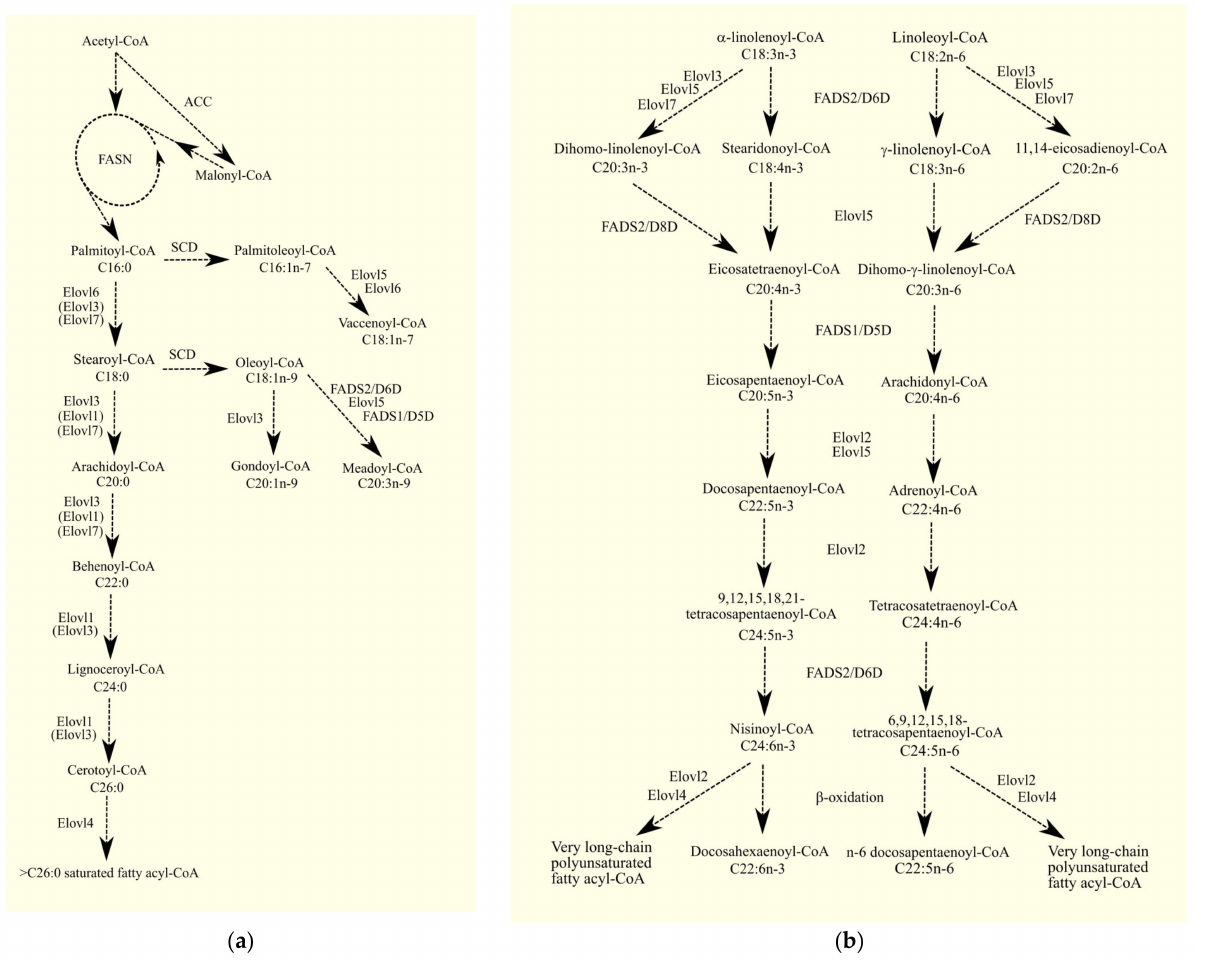
Figure 1. Pathways of fatty acid synthesis. ( a ) The majority of fatty acids are synthesized de novo. Initially, FASN synthesizes palmitoyl-CoA C16:0, but it is unable to elongate the chain further. There- fore, elongases are responsible for the biosynthesis of SFAs longer than 16 carbons. These enzymes elongate fatty acyl-CoA chains by two carbons. Additionally, double bonds can be introduced into acyl-CoA by desaturases. SCD is responsible for the conversion of SFAs to MUFAs, producing oleoyl-CoA C18:1n-9 from stearoyl-CoA C18:0 and palmitoleoyl C16:1n-7 from palmitoyl-CoA C16:0. The desaturases FADS1/D5D and FADS2/D6D are involved in the formation of PUFA, such as meadyl-CoA C20:3n-9, from oleoyl-CoA C18:1n-9. ( b ) In the case of omega-3 and omega-6 PUFA, these fatty acids are formed from other PUFAs of the same series. The elongation of PUFA chains involves Elovl2 and Elovl5 elongases and FADS1/D5D and FADS2/D6D desaturases. DHA is formed through β